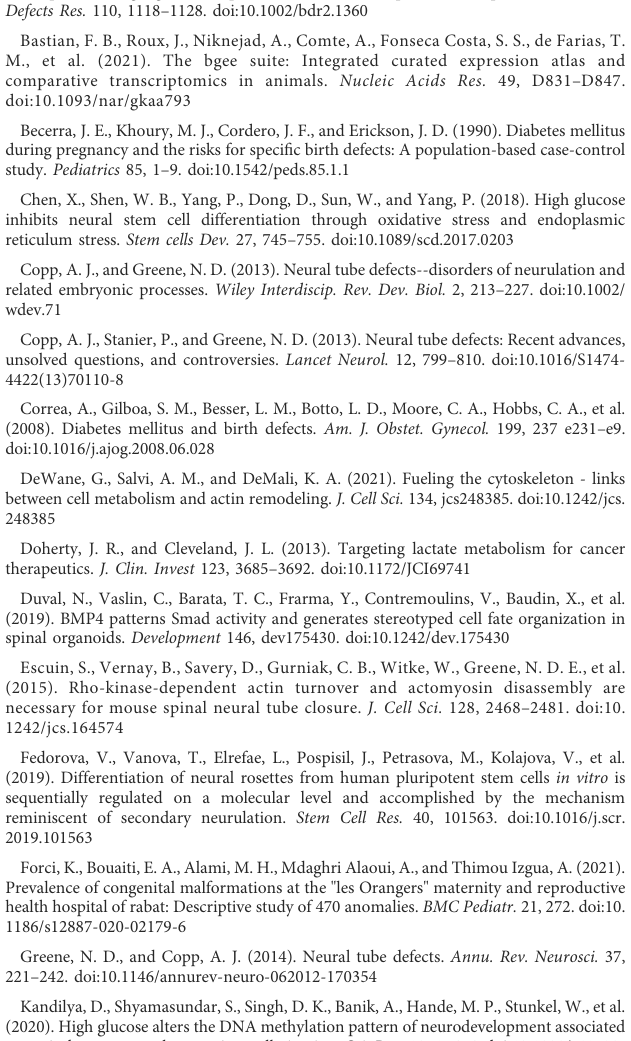
SUPPLEMENTARY FIGURE S3 High glucose had no obvious effect on the distribution of GLUT2, PFKM, PKM2, LDHA, LDHB, and G6PD in the 3D model. Double immuno fl uorescence imagesofF-actin(red)andGLUT2(green), (A) PFKM(green) (B) ,PKM2(green) (C) ,LDHA (green) (D) ,LDHB (green) (E) , orG6PD (green) (F) wereperformed on the 3D models at D2 and 5 from both the normal (NG) and 2x high glucose (HG) groups. N ≥ 6/condition. DAPI (blue) shows the nucleus. Scale bar is 50 μ m. SUPPLEMENTARY FIGURE S4 HK1 distribution in the rosette model. Representing images of (A) HK1 (green), (B) TOM20 (red), and (C) double staining of HK1 (green) and F-actin (red) in normal (NG) and 2x high glucose (HG) groups at D4 after passage. N ≥ 6/ condition. All scale bar = 50 μ